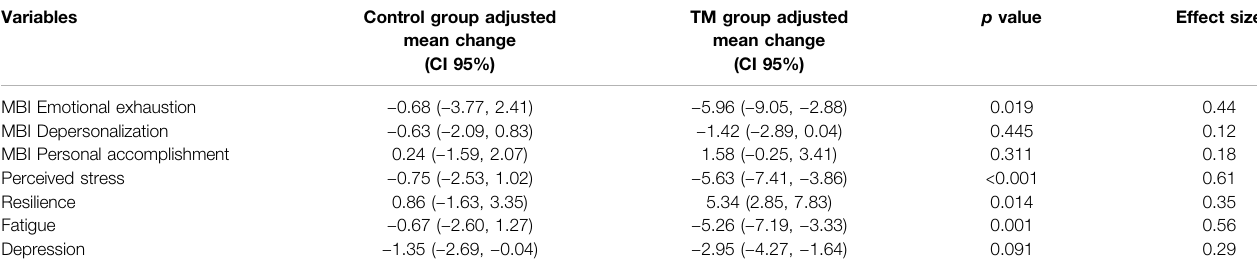
TABLE 2 | Between-group comparisons of study outcomes.